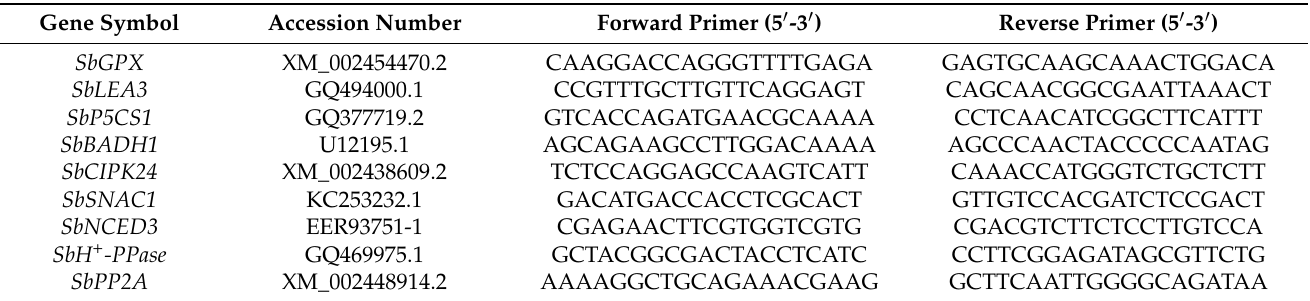
Table 2. Description of primers used for real-time